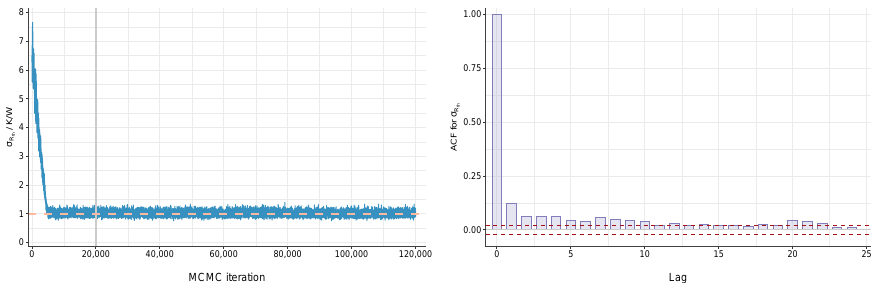
Figure 5. MCMC diagnostics for σ R for a single dataset of E1 ( n 2 = 100, Issue 1): ( left ) trace plot th with true values (red dashed line) and burn-in phase (gray line); ( right ) ACF plot after thinning and the burn-in phase.